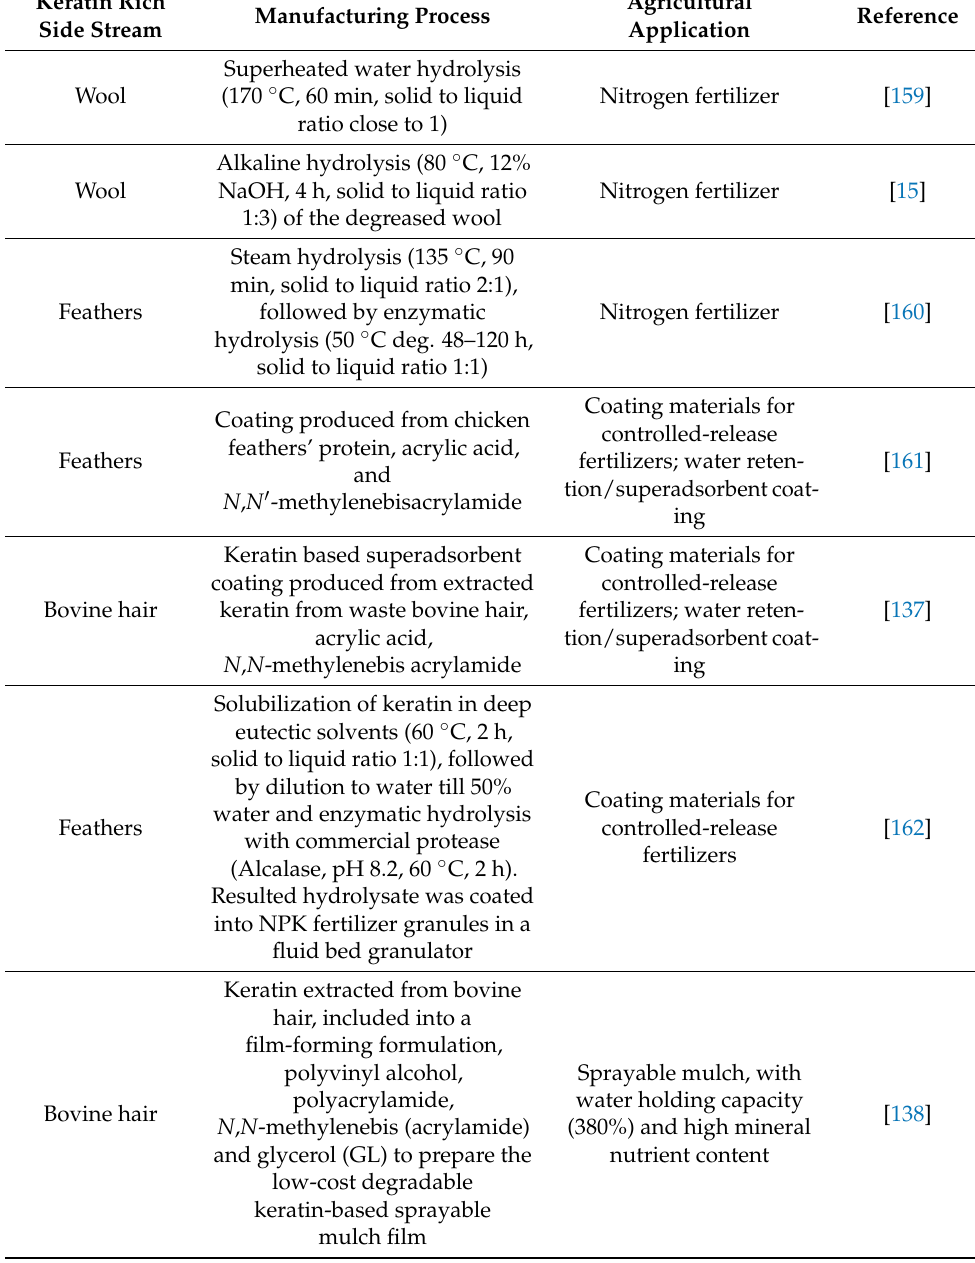
Table 9. Application of the extracted keratin for the production and/or formulation of the agricultural